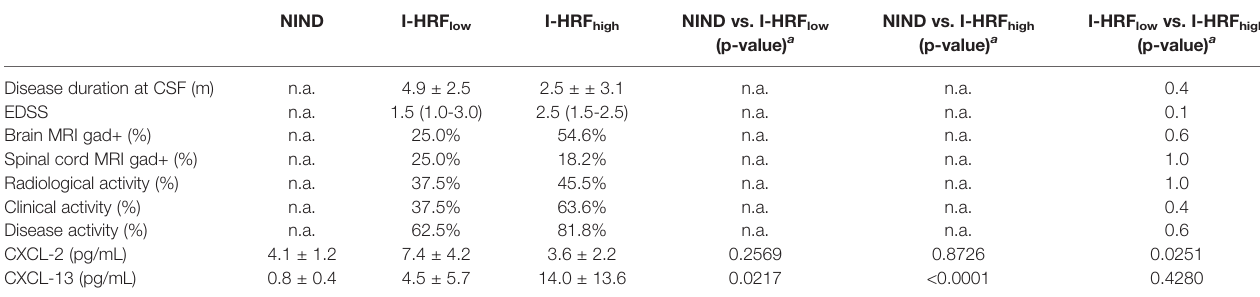
TABLE 3 | CSF concentrations of cytokines correlating with INL HRF